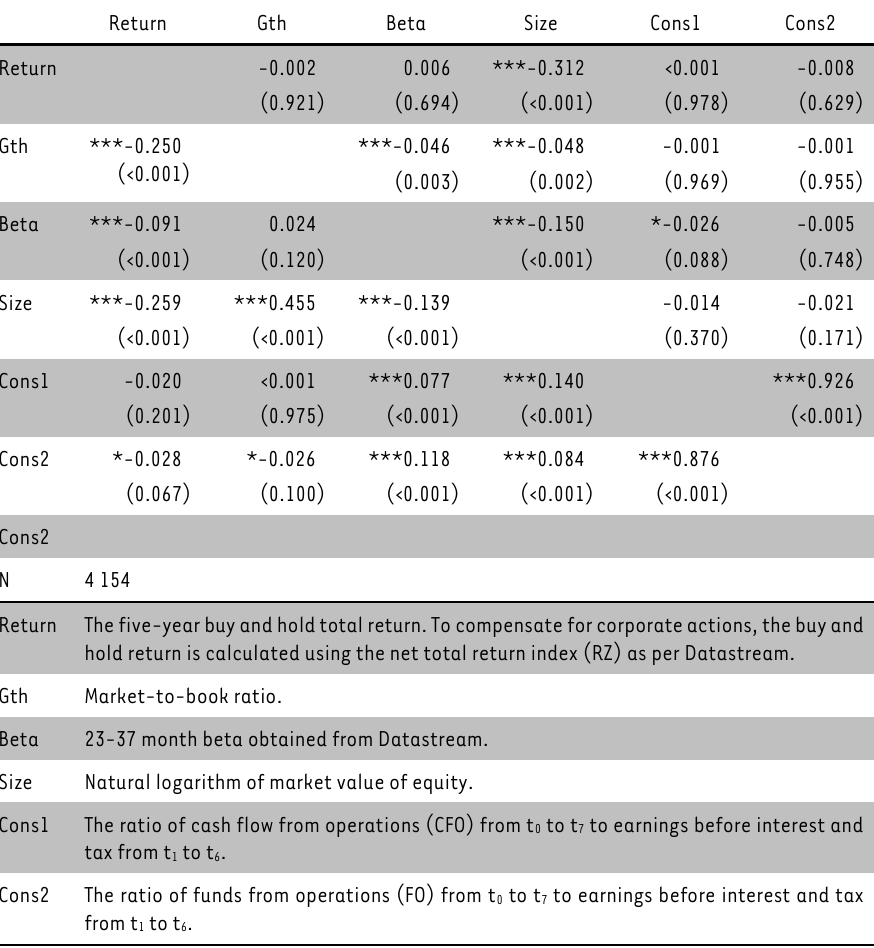
TABLE 2: Univariate